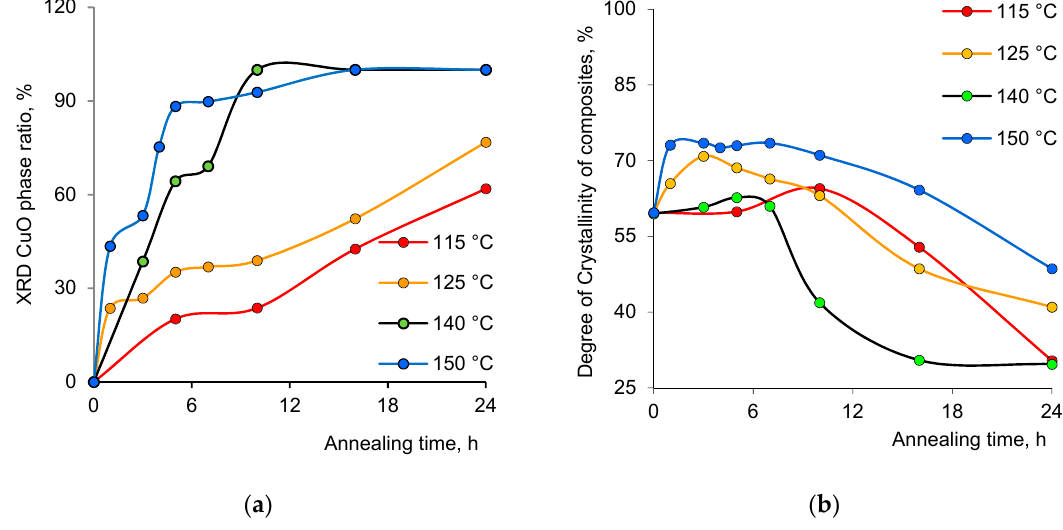
Figure 2. ( a ) Change of tenorite CuO phase ratio and ( b ) the degree of crystallinity (DC) of the composites depending on time and temperature of annealing.